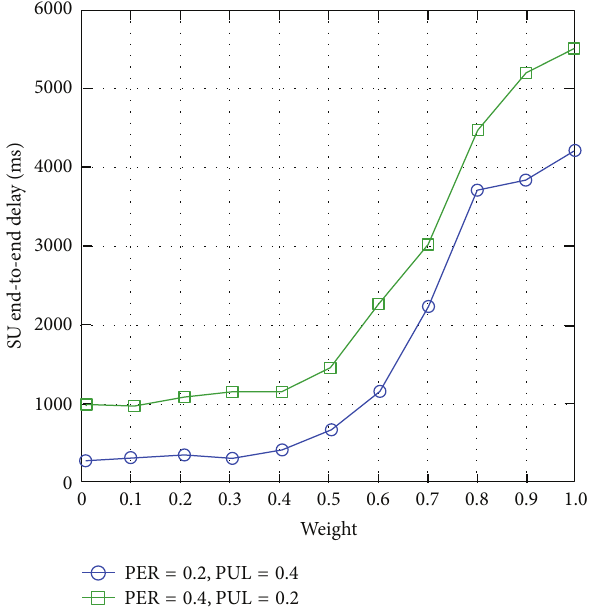
Figure 7: SU end-to-end delay for varying weight factor 𝜔 .